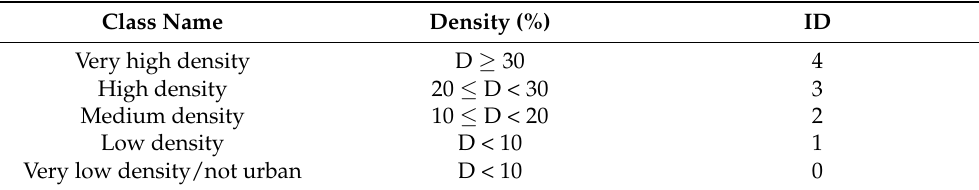
Table 1. Details of the preliminary urban density classification. The class “low density” is not assigned at this